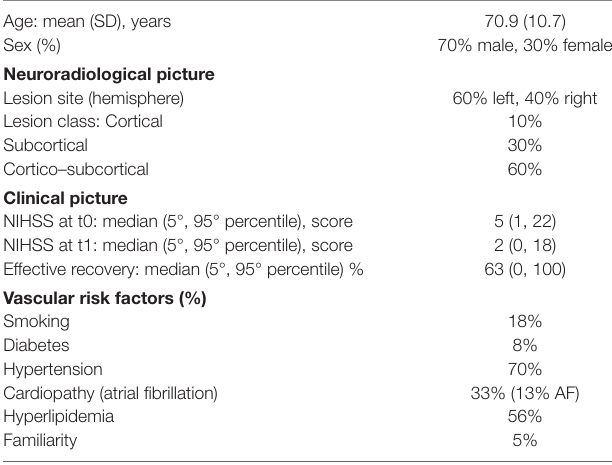
Table 1 | Patients’ personal and clinical data ( n =